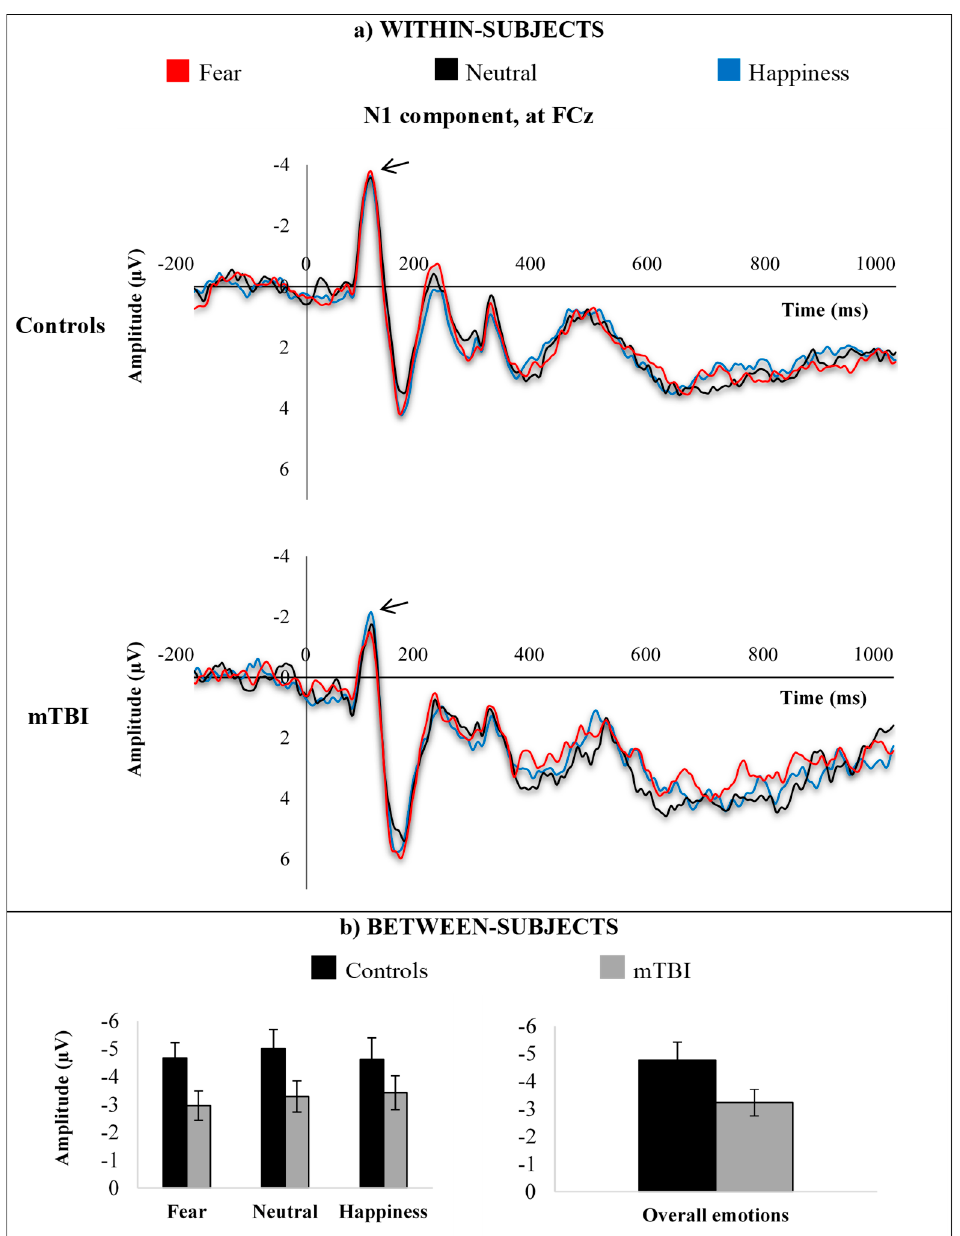
Figure 3. N1 responses at FCz electrode site, ( a ) within-subjects and ( b ) between-subjects, according to emotional expressions (fear, neutrality, happiness).